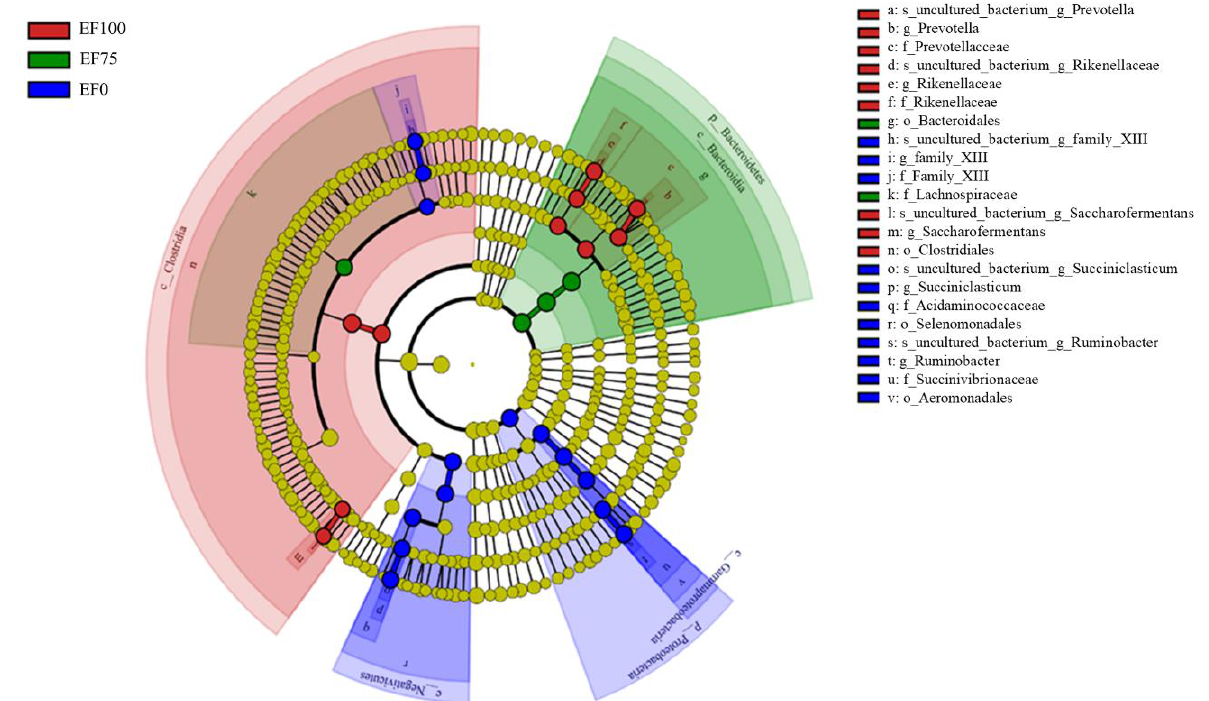
Figure 6. Cladogram of bacterial biomarkers from phylum (innermost ring) to genus (outermost ring) level, LDA score > 4. Differential bacterial taxa were marked with lowercase letters. The small circle of each different classification level represents the taxon of that level, and circle is directly proportional to the relative abundance. The principle of coloring is to use color the species. There was no significant difference in yellow, whereas other differential species are colored according to the group with the highest abundance. Different colors represent different groups, and nodes with different colors represent communities that play an important role in groups represented by colors. Table 5. The relative abundance of the rumen microbiome was significantly altered with espect to Kyoto Encyclopedia of Genes and Genomes (KEGG) terms (>1.5% in at least one sample) in rumen fermentation fluid after in vitro fermentation with different levels of endophyte-free Achnatherum inebrians (EF).